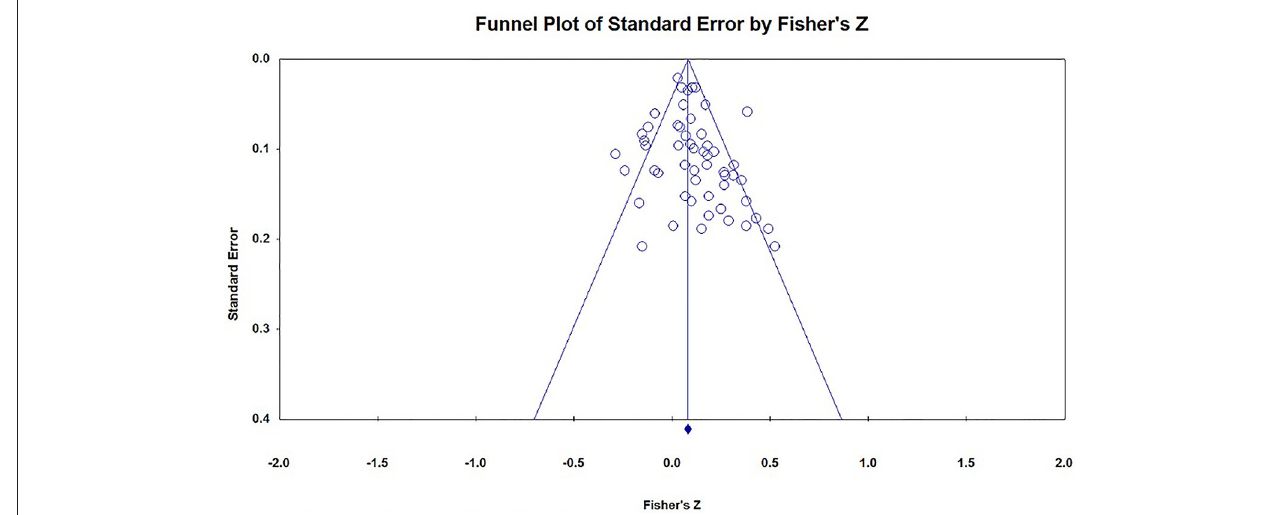
FIGURE 2 | Funnel plot of all the effect size ( x = 55).